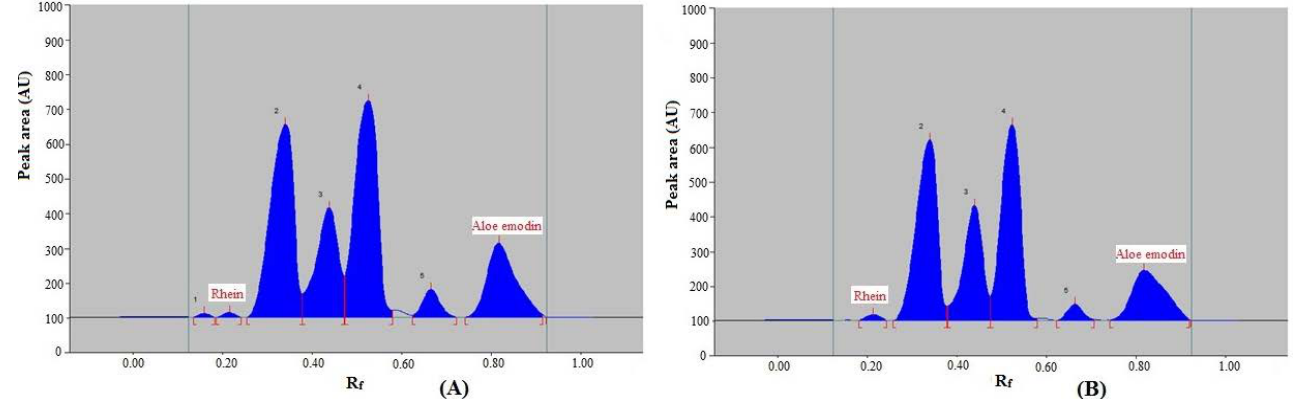
Figure 6. Sustainable reverse-phase HPTLC densitograms of rhein and aloe-emodin in ( A ) UBE of marketed Rhubarb extract and ( B ) UBE of Rhubarb plant extract.